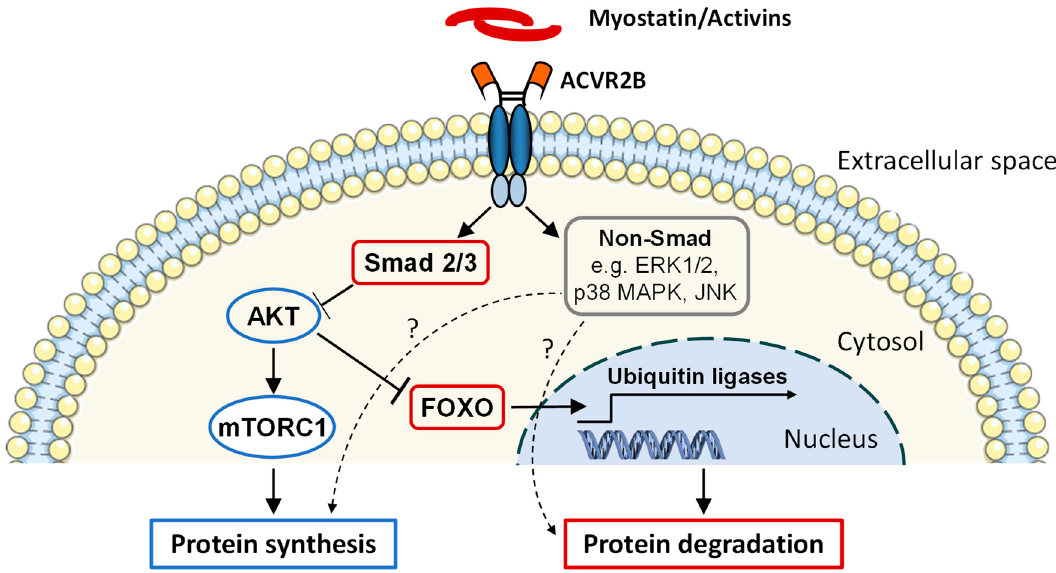
Figure 2. A simplified illustration of intracellular signaling induced by binding of myostatin or activins to their receptor activin receptor type 2B (ACVR2B). Cell membrane and DNA images were adapted from https://smart.servier.com (accessed on 23 February 2021) (Modified from Reference [135]).